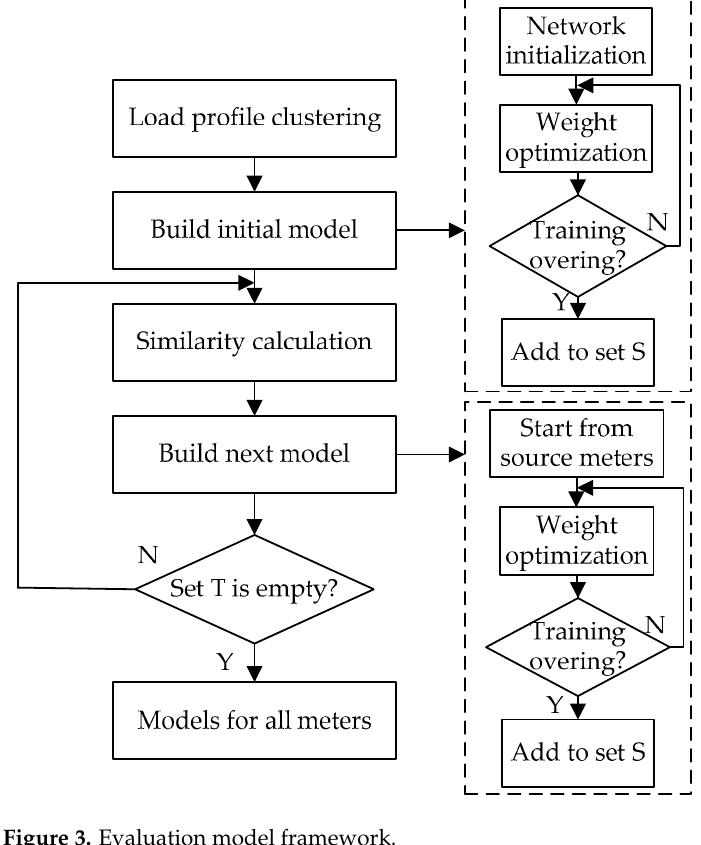
Figure 3. Evaluation model framework.